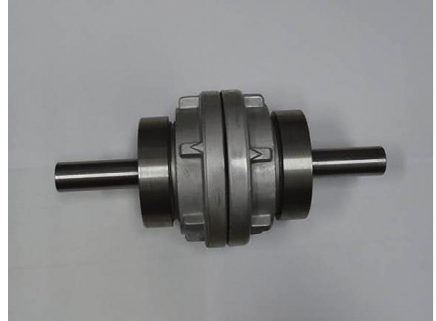
Figure 26: Back view of the joint.